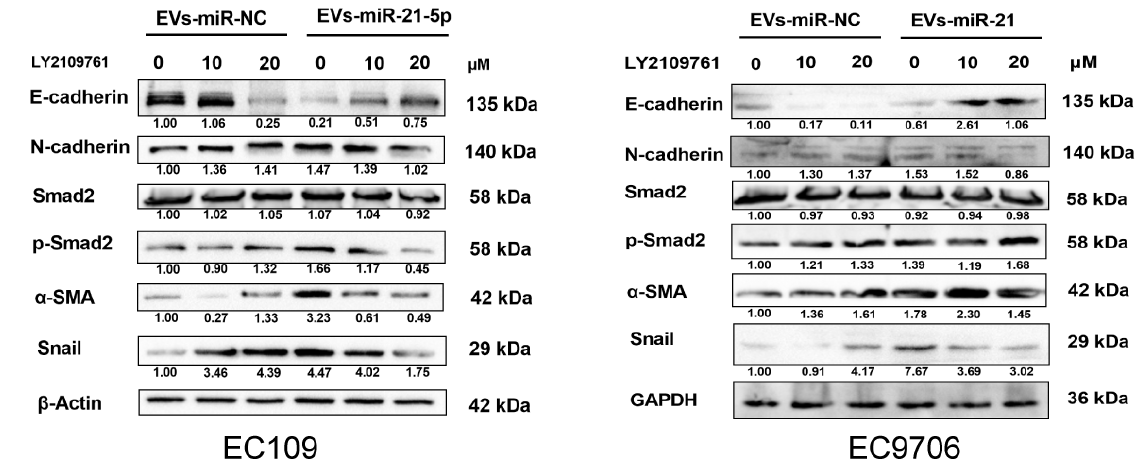
Figure 7. EVs-miR-21-5p derived from M2 macrophages promotes esophageal cancer cell EMT through TGF-β signaling. Western blotting analysis of E-cadherin, N-cadherin, α-SMA, Snail, Smad2, and p- Smad2 expression in EC109 or EC9706 at different dosages of LY210976 (0, 10, and 20 µM). The relative protein level was normalized to β-actin or GAPDH.